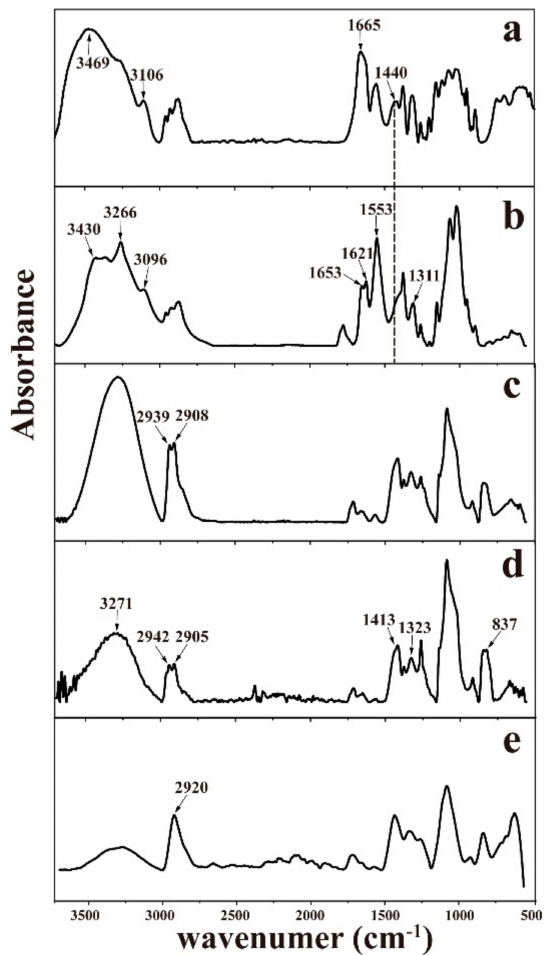
Figure 2. FTIR spectrum of the chitin powder ( a ), ChWs film ( b ), PVA/ChWs composite films ( c ), pure PVA films ( d ) and heat treated PVA/ChWs composite films ( e